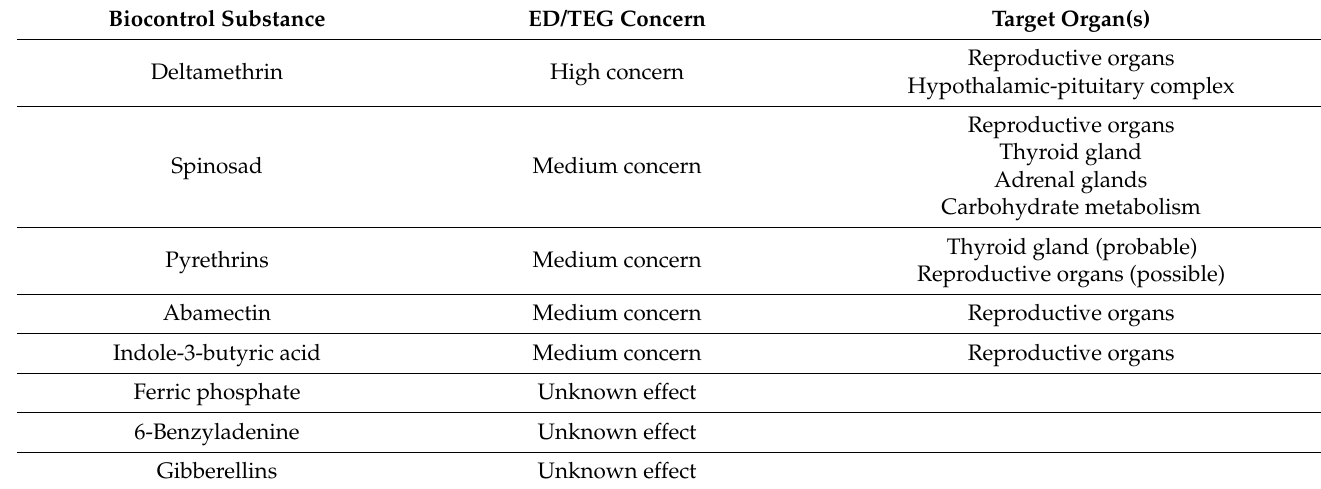
Table 4. Phytopharmaceutical active substances for biocontrol licensed in 2018 and their levels of concern about endocrine disruption or toxicity for endocrine glands (ED/TEG)with target